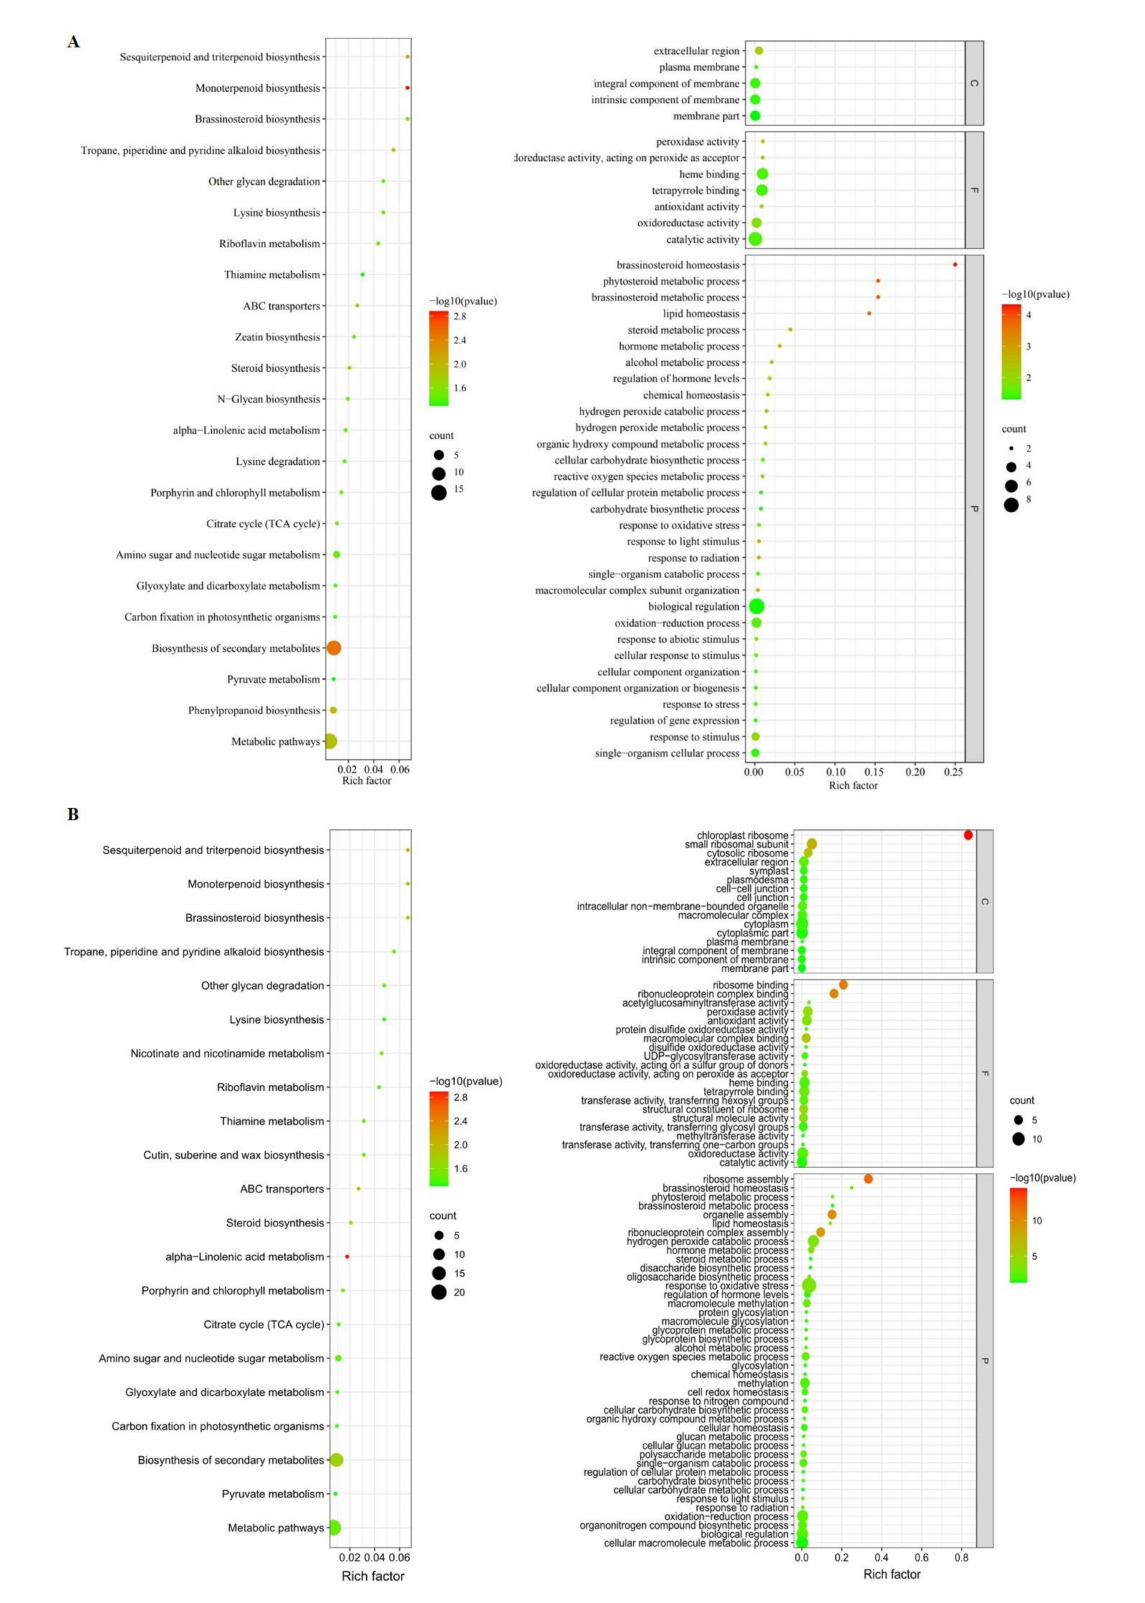
Figure 4. GO terms and KEGG pathways enriched by the genes associated with 36 phenotypic traits. ( A ) GO terms and KEGG pathways enriched by 130 unique candidate genes. ( B ) GO terms and KEGG pathways enriched by 100 shared associated genes. Left: KEGG pathways. Right: GO items. C represents cellular component, F represents molecular function, and P represents biological